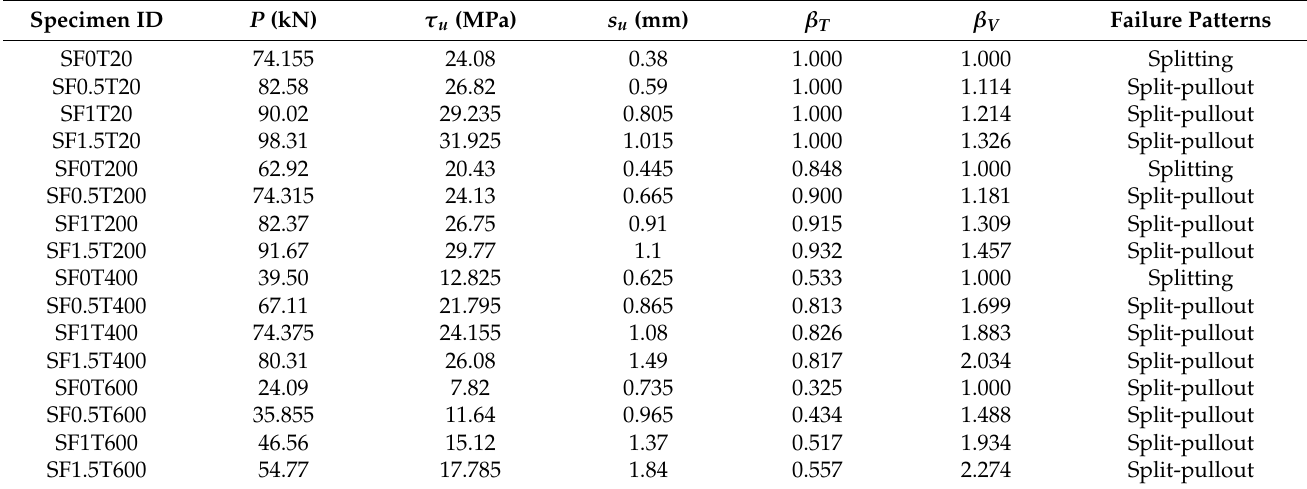
Table 5. Experimental results of pull-out